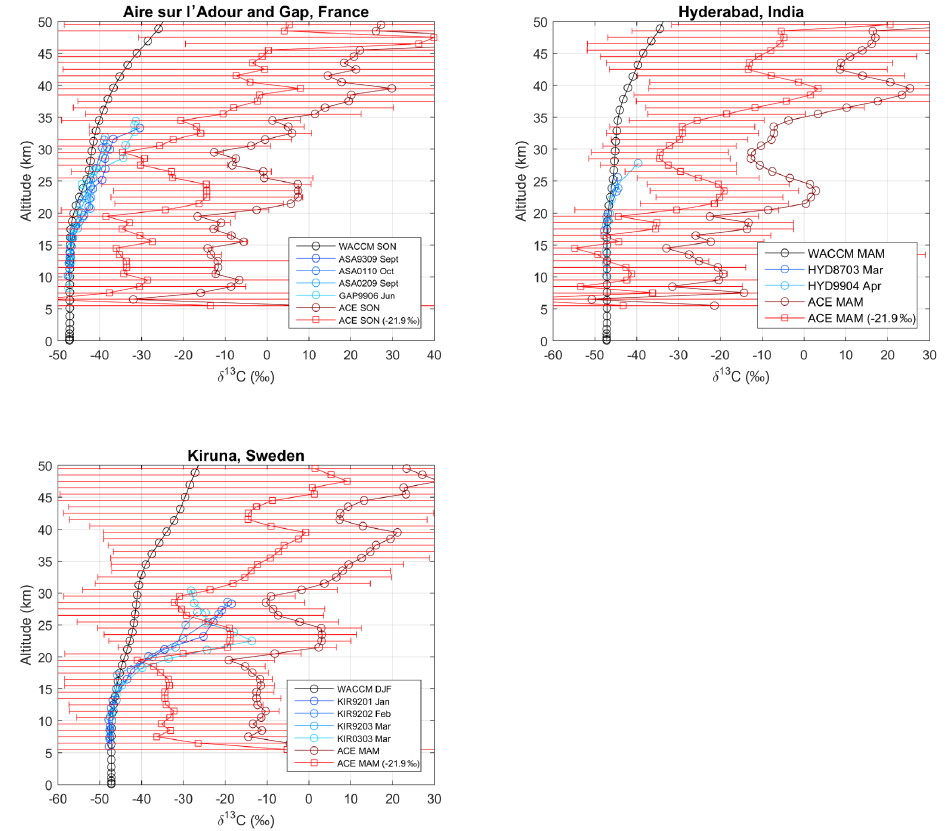
Figure 14. Comparison of δ 13 C profiles from ACE before and after calibration, WACCM, and balloon profiles from Röckmann et al. (2011).